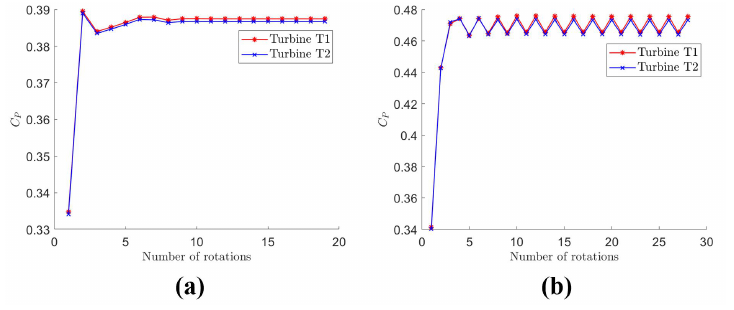
Figure 18. Examples of the convergence behavior of the 2 turbines for 2 cases: Forward at ω t = 12.5 rad/s ( a ) and forward at ω t = 14.5 rad/s ( b